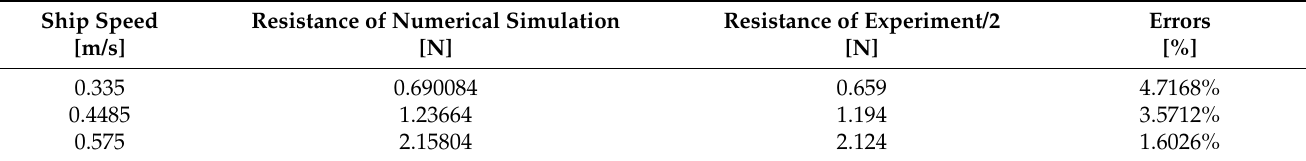
Table 4. Comparison of resistance between simulation and experiment.